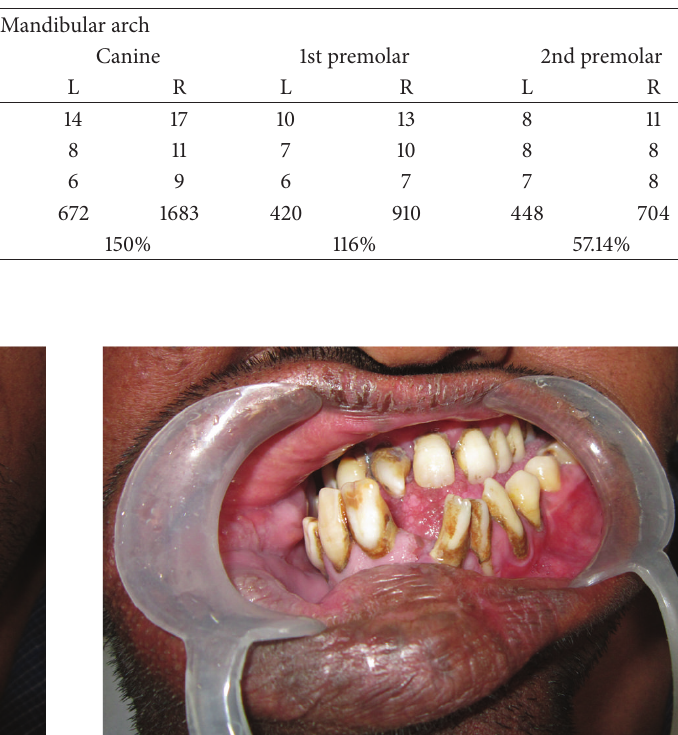
Table 2: Comparison of crown sizes of the mandibular teeth.